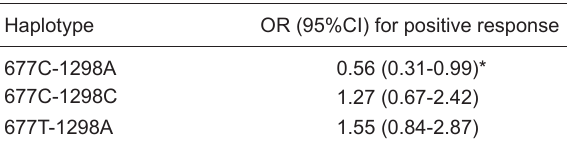
Table 4. Univariate logistic regression models predicting odds ratios for patients’ response to treatment in relation to 677-1298